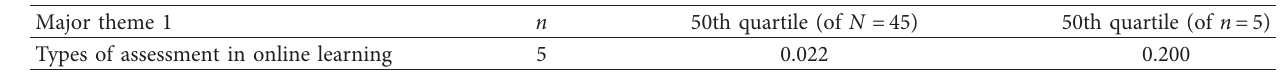
Table 12: 50th quartiles of types of assessment in online